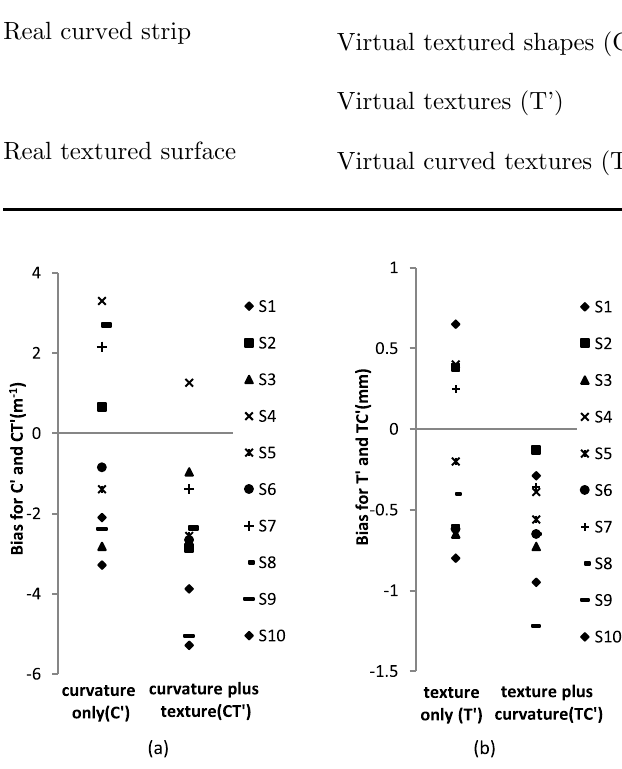
Fig. 7. Results of Exp. 2. Individual perceptual biases. (a) under Conditions C ’ and CT ’ ; (b) under Conditions T ’ and TC ’